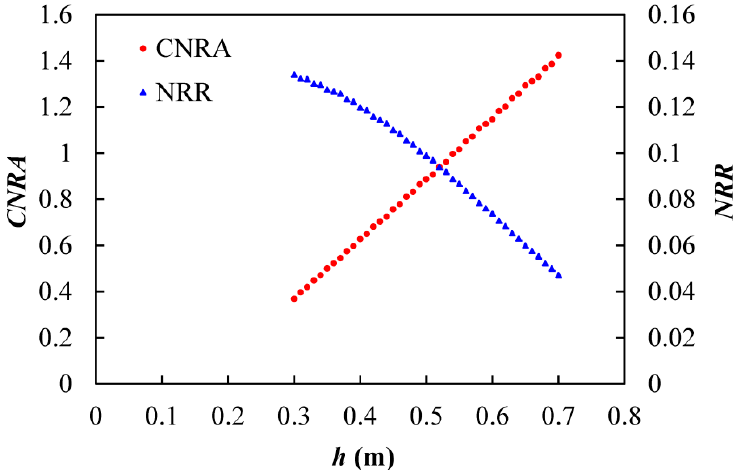
Figure 7. Relationship of the cumulative nitrogen removal amount ( CNRA ) and nitrogen removal ratio ( NRR ) with the height of the weir ( h ).